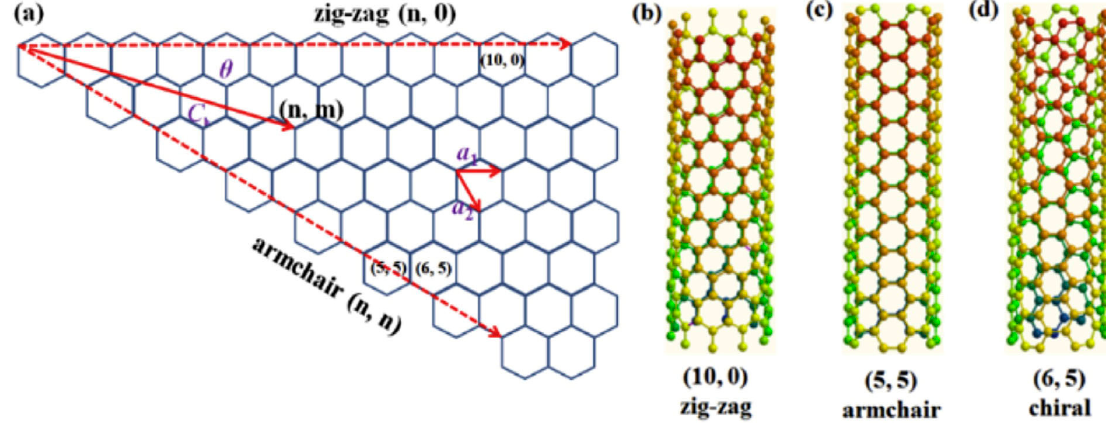
Figure 1. Geometries of CNTs. Reproduced with permission from [19]. Copyright Elsevier, 2016.